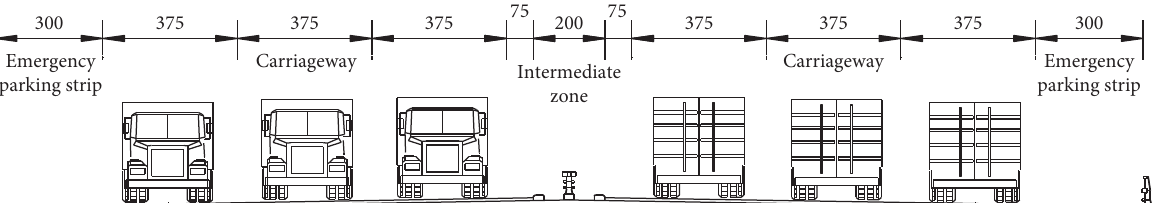
Figure 2: Bridge finite element model.